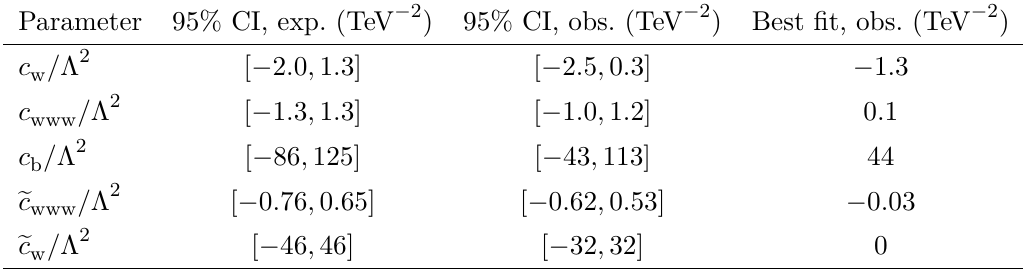
Table 12 . Best fit, and expected and observed one-dimensional confidence intervals at 95% con- fidence level for each of the considered EFT parameters. Both the purely dimension-eight BSM contribution as well as the dimension-six interference term are included to compute the EFT effect in the high tails of M (WZ) for these results. In computing confidence intervals for each parameter the other ones are fixed to their SM